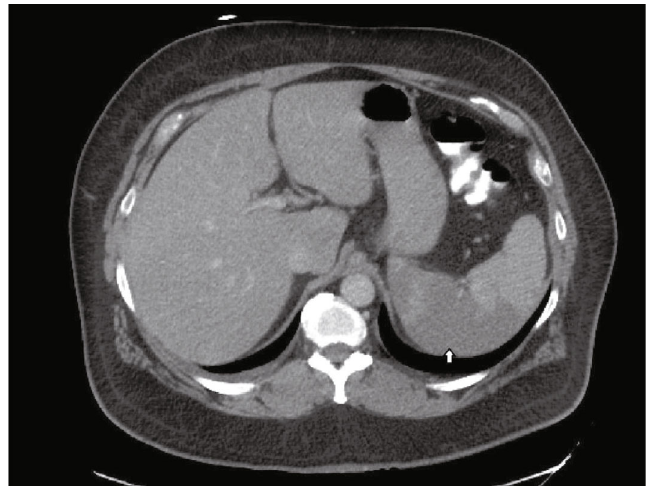
Figure 1: An area of hypodensity involving the right half of the spleen consistent with splenic infarction (arrow).